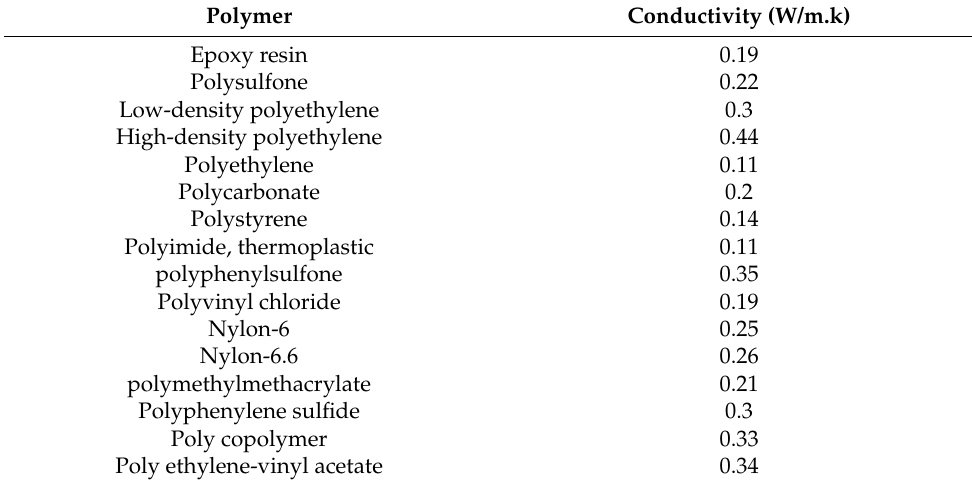
Table 4. Thermal conductivities of